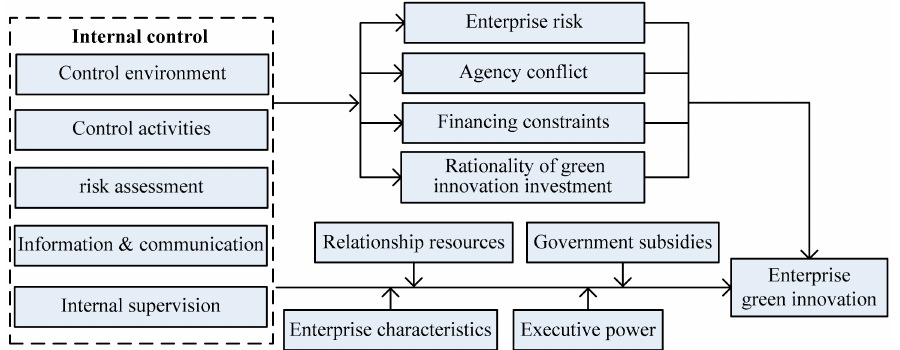
Figure 1. Diagram of the research